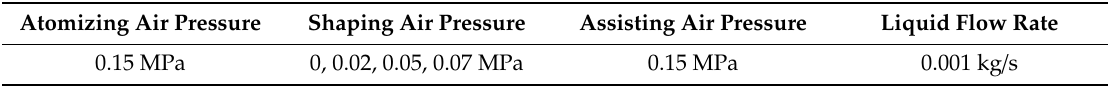
Table 1. Application parameters used in the simulations.